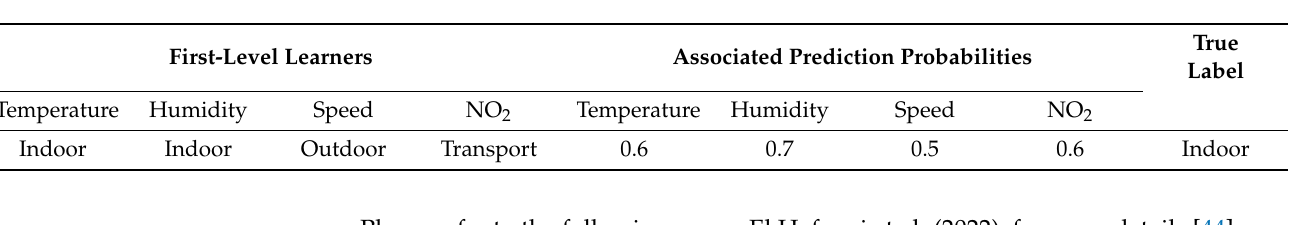
Table 2. Input raw data of the meta-learner. This example shows the output of the first-level learners on four views (temperature, humidity, speed, and NO 2 ), the predicted environment, and the prob- ability. For instance, the first-level learner predicted “transport” with a probability of 0.6.